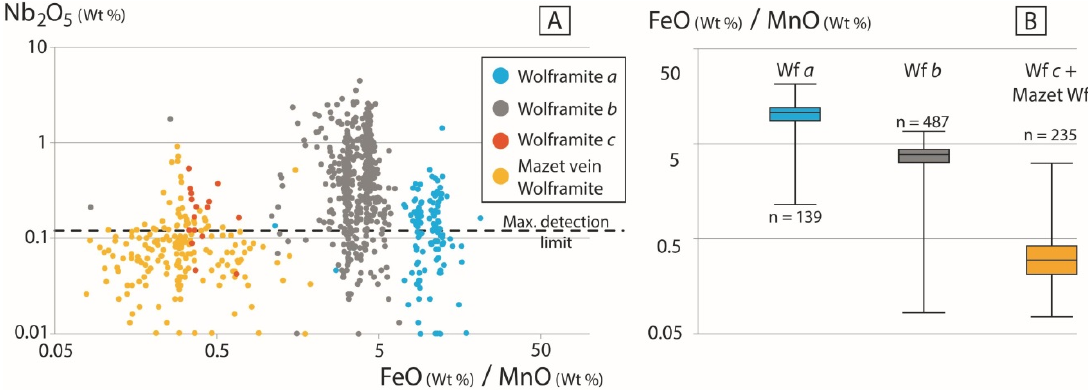
Figure 10. Compilation of all wolframite electron probe microanalyser (EPMA) data highlighting three distinct regions in FeO / MnO space ( A and B ) and a spread in Nb content as a function of this ratio ( A ). Boxplots illustrate the minimum, maximum, and three quartile values for each wolframite group ( B ). The detection limit shown in ( A ) corresponds to maximal